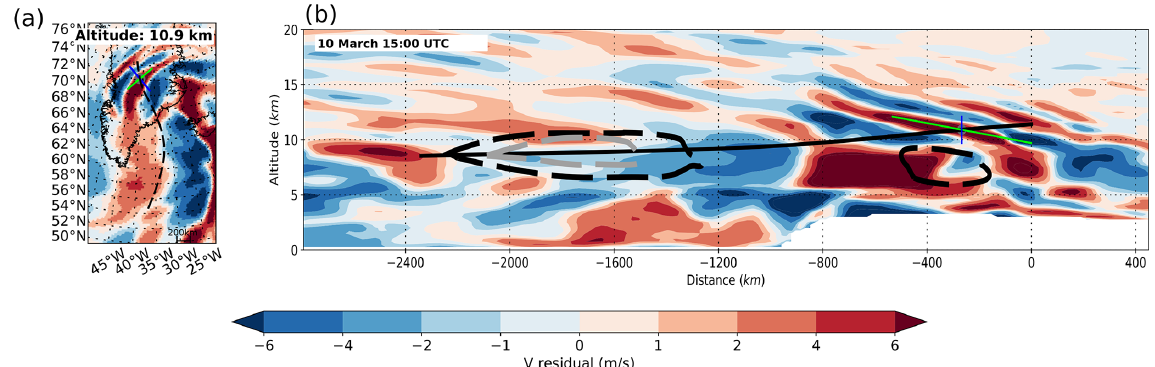
Figure 5. GROGRAT back tracing of ray no. 2 and meridional wind ( v ) residuals from ERA5. The back tracing starts at 11.4km (on 10 March at 18:00UTC) and ends at 8.5km (on 9 March at 18:00UTC). (a) The horizontal cross section of the ray path (dashed black line) and the corresponding v -residual wind speeds at 10.9km. (b) The vertical cross section of v -residual wind speeds along the ray path (solid black line). Ray tracing started at ray reference time 42h (flight time), and both (a) and (b) are valid for 13:00UTC (5h prior to ray initialisation). The cross of the blue and green line represents the position of the GW at the respective time; the blue line indicates one horizontal (vertical) wavelength in the horizontal (vertical) cross section, and the green line indicates the orientation of the phase fronts, all calculated in GROGRAT. The thick dashed black line indicates cross-stream ageostrophic wind values in excess of 7.5ms − 1 . The encircled dashed area at − 1500km occurred between 24–19h before ray initialisation (the back trace passed through this area at the same time). The encircled dashed area at − 400km represents an out-of-balance jet at 2–7h before ray initialisation.